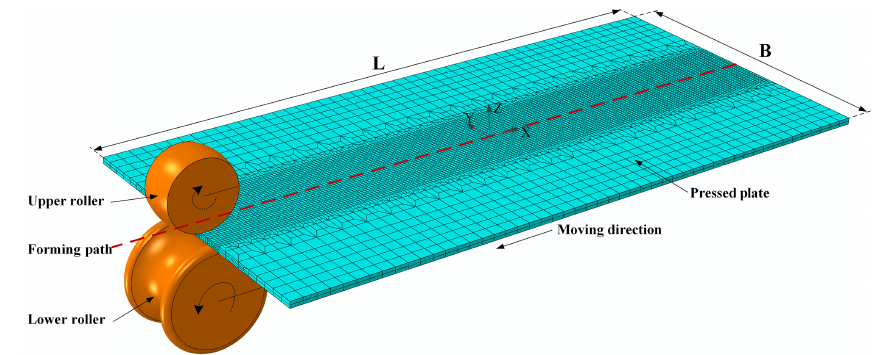
Figure 2. Finite element model and mesh generation for local line rolling forming.